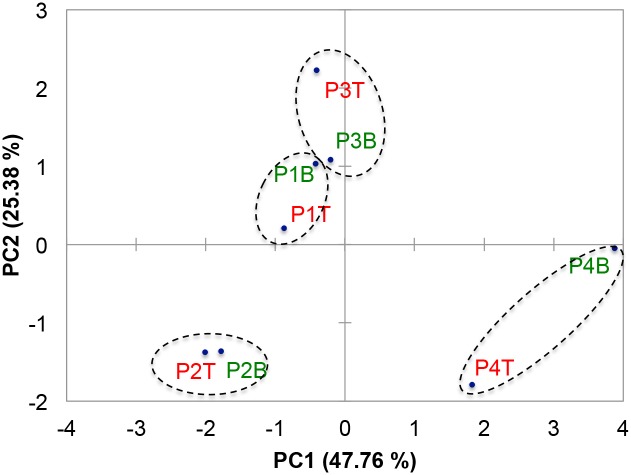
Two dimensional principal component analysis (2D PCA) scores plot demonstrates statistical clustering of top (T) and bottom (B) biopsies of the same wounds (n = 4) rather than statistical clustering dependent on biopsy depth based on analysis of relative bacterial abundance.